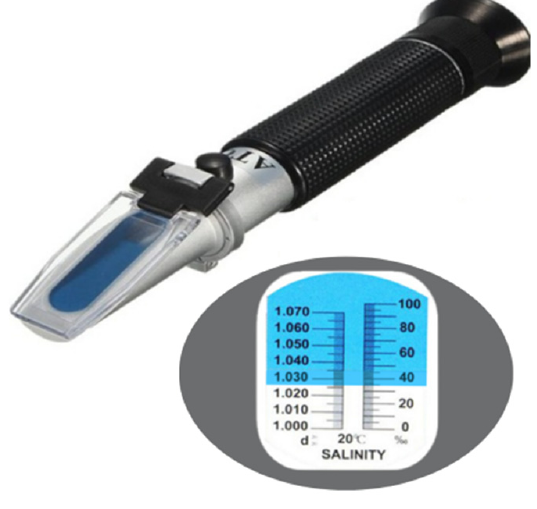
Figure 2. Refractometer salinity.